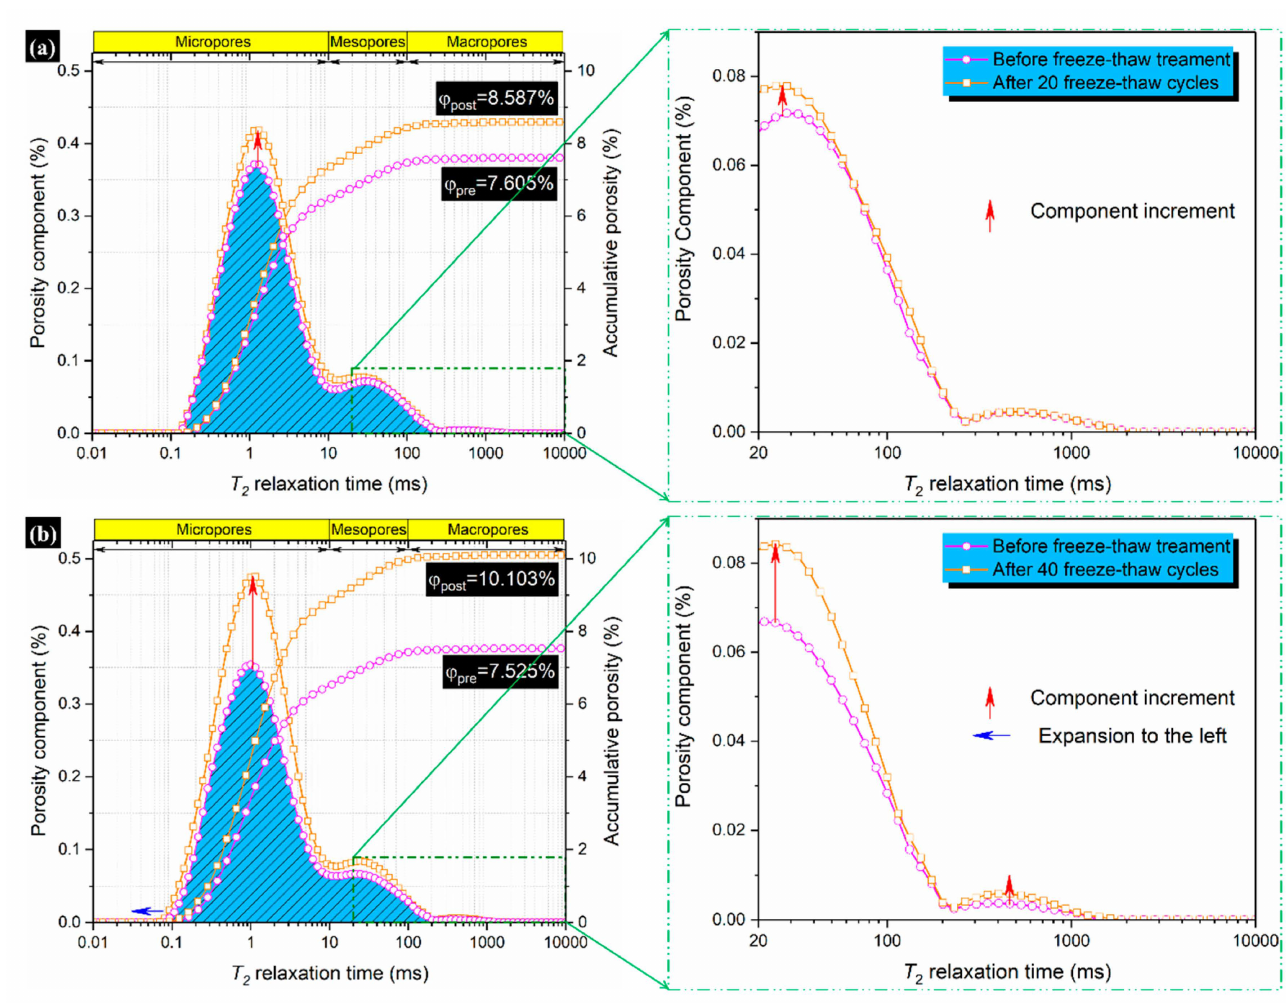
Figure 5. T 2 spectrum distribution curves for sandstone specimens at different quantities of F&T